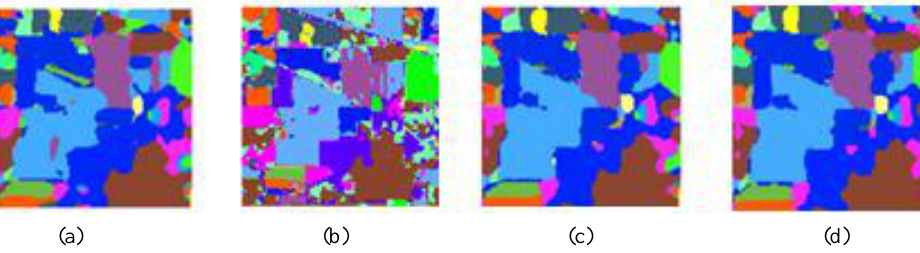
Figure 6. Indian Pine. (a)– (d) Classification maps for different classifiers: (a) Chen’s Method with OA=92.42%, (b) Ghamisi’s Method with OA=86.62%, (c) Paoletti’s Method with OA=94.93% (d) GACNN (proposed) with OA=97.91%